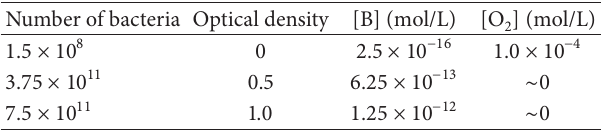
Table 4: Relationship between number of bacteria, optical density readings, and the concentrations of B and O